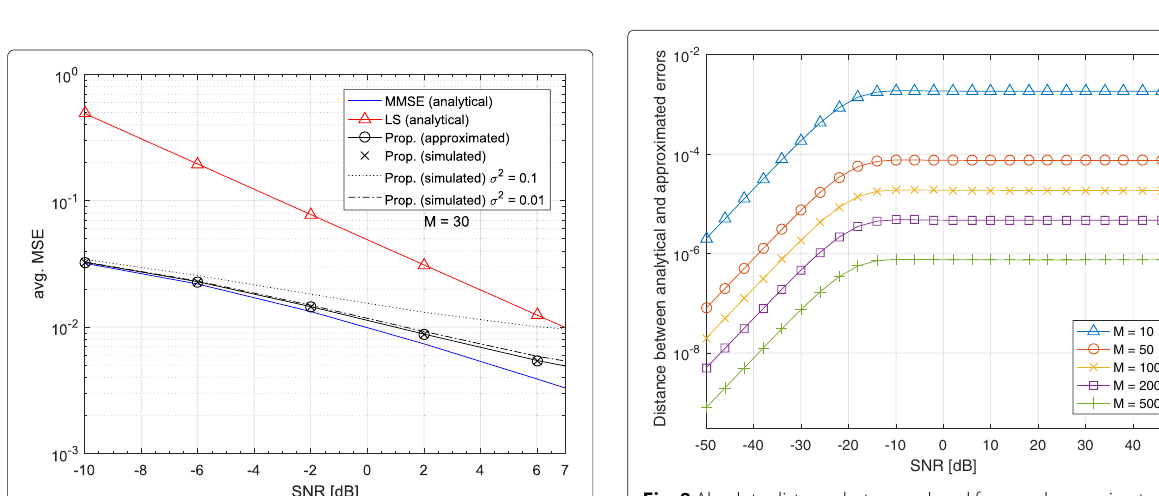
with pilot contamination in a flat channel environment.